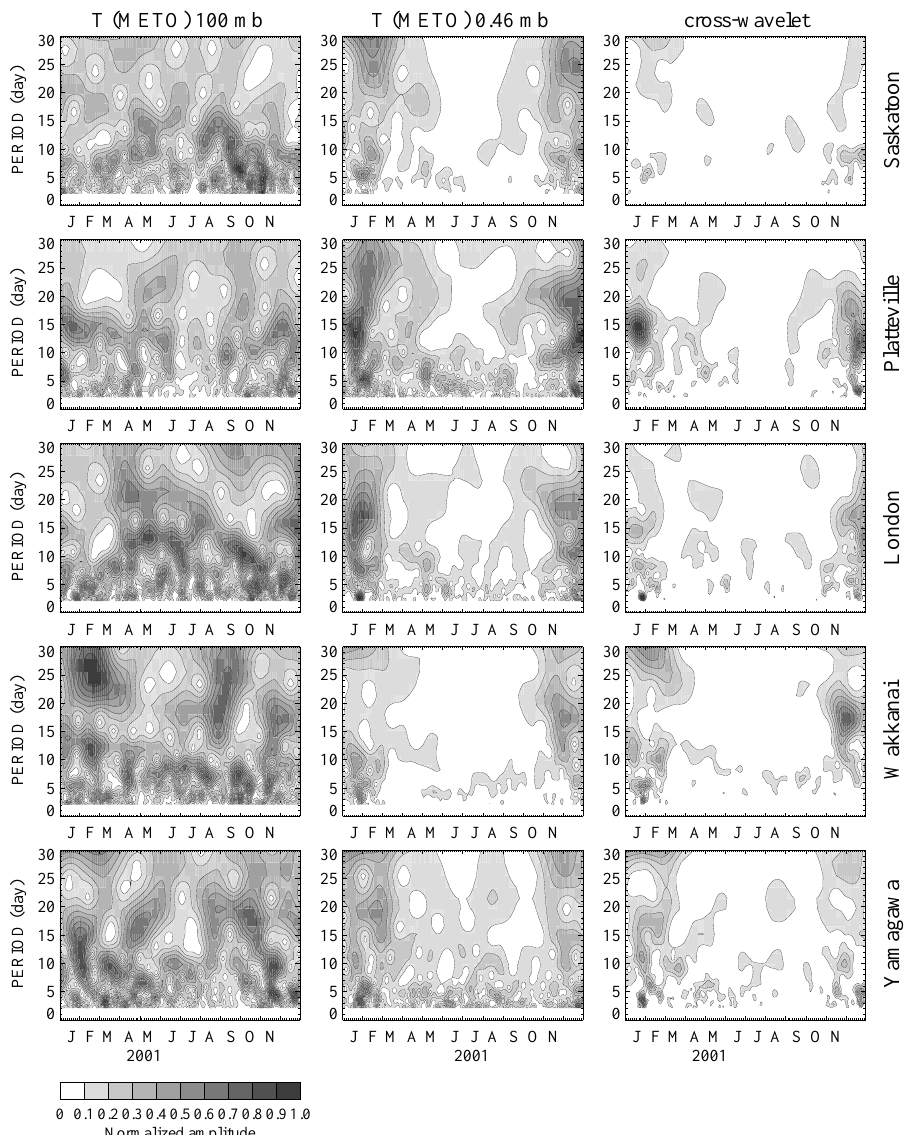
Fig. 5. The same as Fig. 4, but for MetO temperature at 100mbar and 0.46mbar pressure